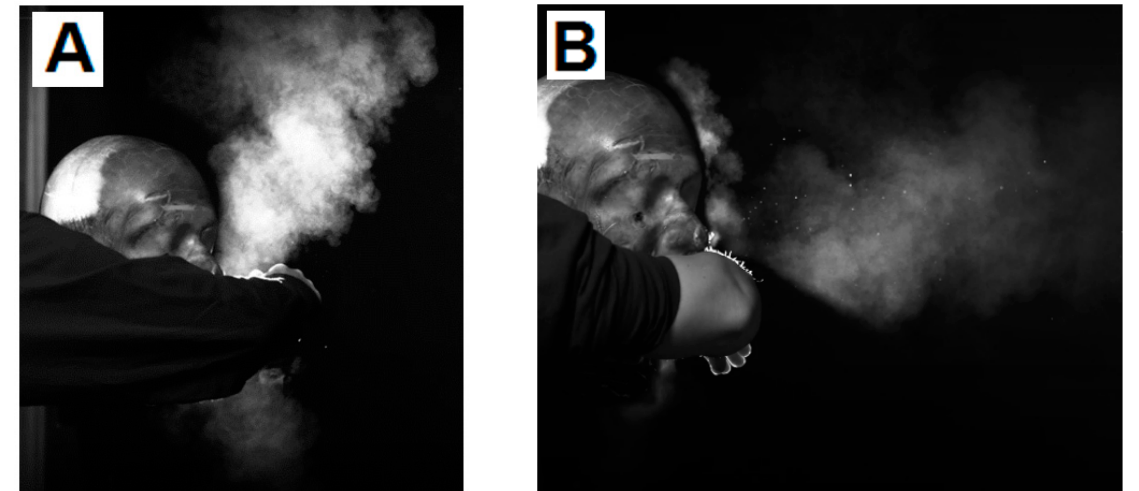
Figure 9. High-speed backlit photographs of the cough with ( A ) a sleeved elbow and ( B ) the elbow touching the mouth.